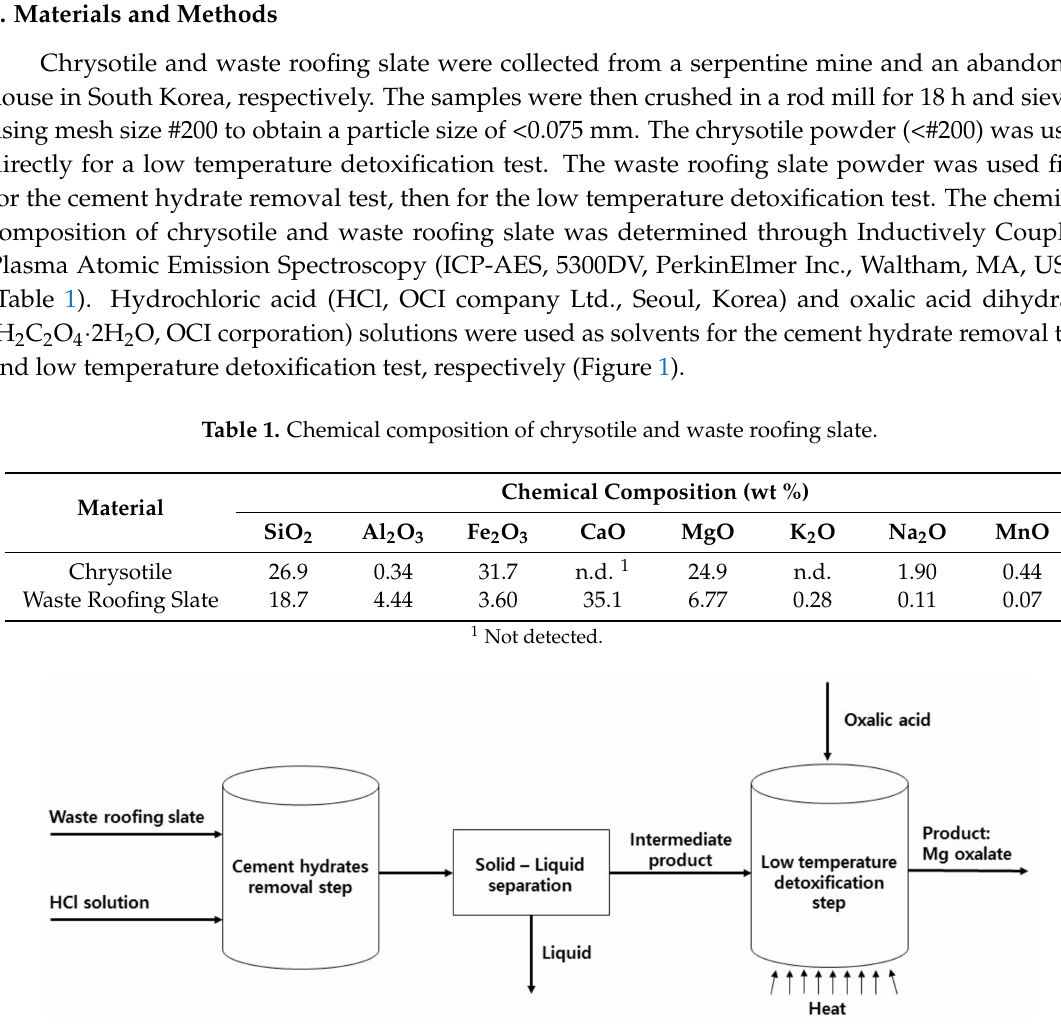
Figure 1. Schematic diagram of process route used in this study.